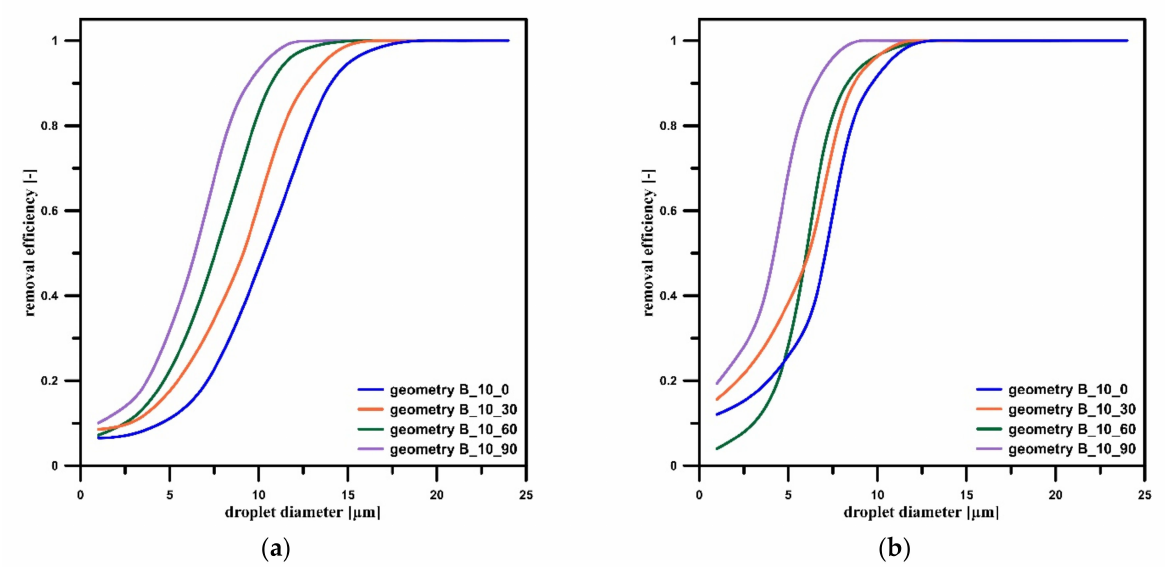
Figure 12. Comparison of calculated results of droplet removal efficiency for geometries with different drainage channel angles with inlet velocity: ( a ) 2 m s − 1 ; ( b ) 4 m s − 1 .